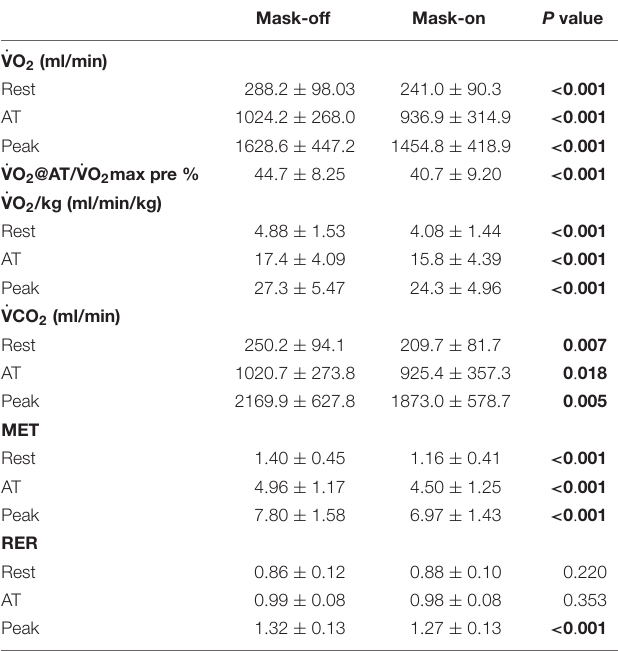
TABLE 3 | The comparison of metabolic reaction parameters between mask-on and mask-off